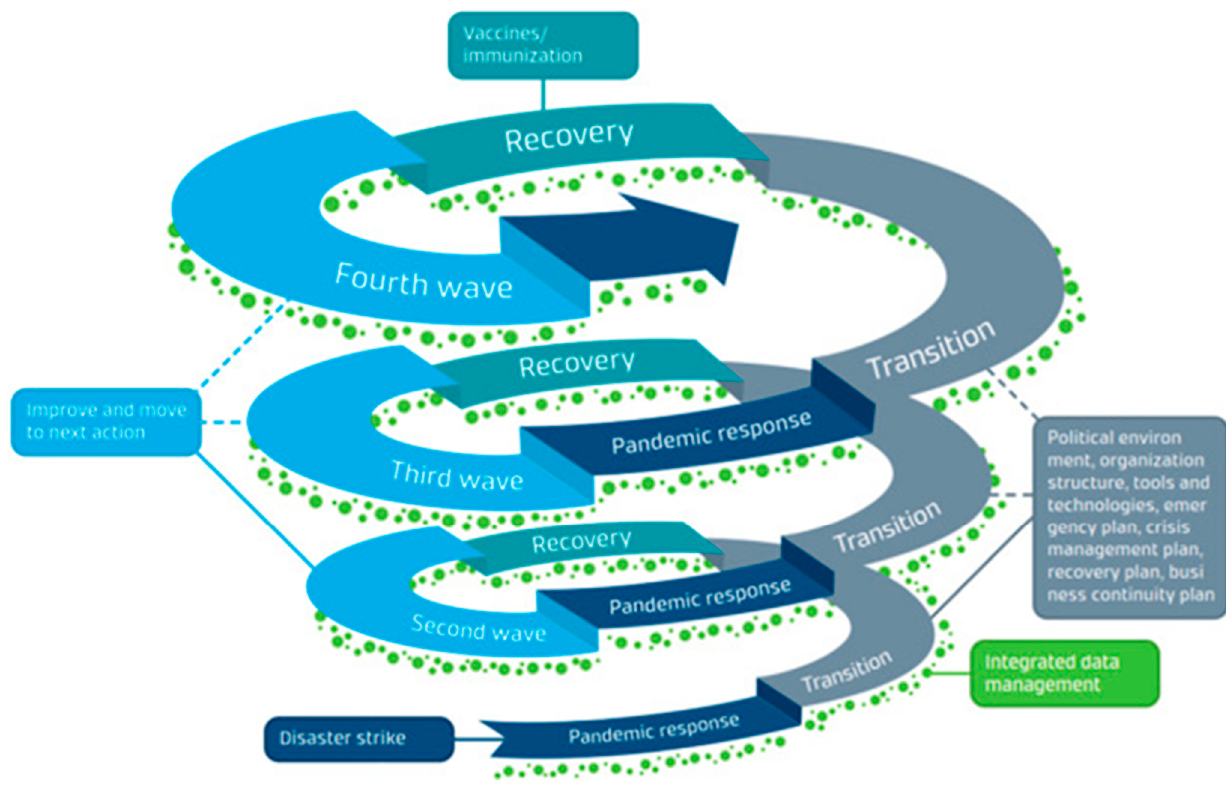
Figure 3. Complex nature of a pandemic management cycle involves “transitioning from pandemic response to recovery in a spiral fashion” [45]. Reproduced unmodified with permission of the author.